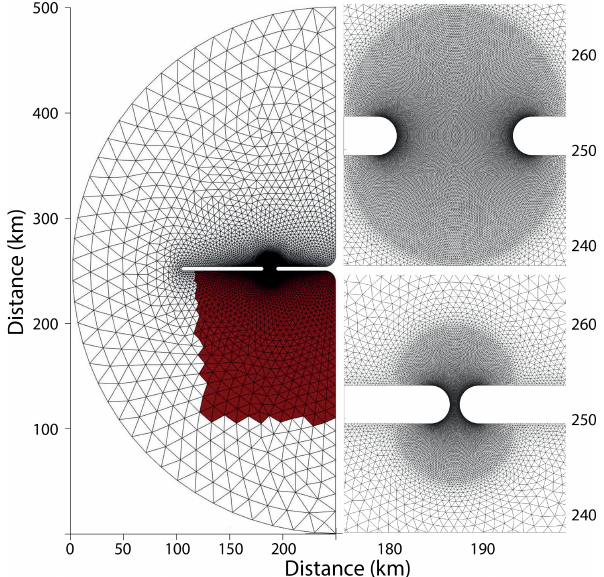
Figure 2. Left panel: the entire model domain with the peninsula at- tached to the eastern coast and the island located west of the penin- sula. Red marks the area with initial tracer concentration equal to 1m − 3 . Right panel: the mesh near the strait with 12km width (top) and 1km width (bottom).